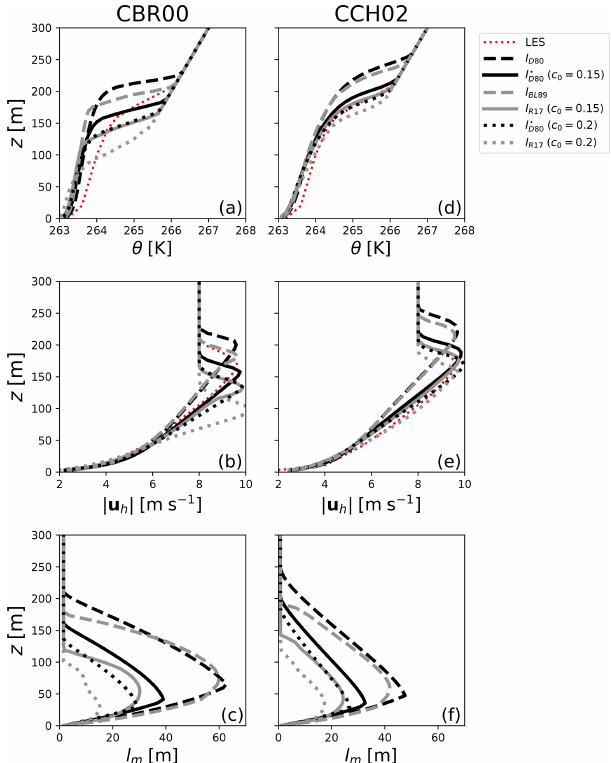
Figure 5. Results obtained for the stably stratified boundary-layer case of Cuxart et al. (2006) for the parameter values CBR00 (left panels, a to c ) and CCH02 (right panels, d to f ) with different mixing-length formulations: l D80 for black solid lines, l (cid:63) c 0 = 0 . 15 for dashed black lines ( c 0 = 0 . 2 for dotted black lines), l BL89 for solid gray lines, and l R17 with c 0 = 0 . 15 for dashed gray lines ( c 0 = 0 . 2 for dotted gray lines). Results are shown for poten- tial temperature θ (a, d) , wind speed (b, e) , and l m (c, f) . Dotted red lines represent LES results from Rodier et al. (2017). Instantaneous profiles after 9h are